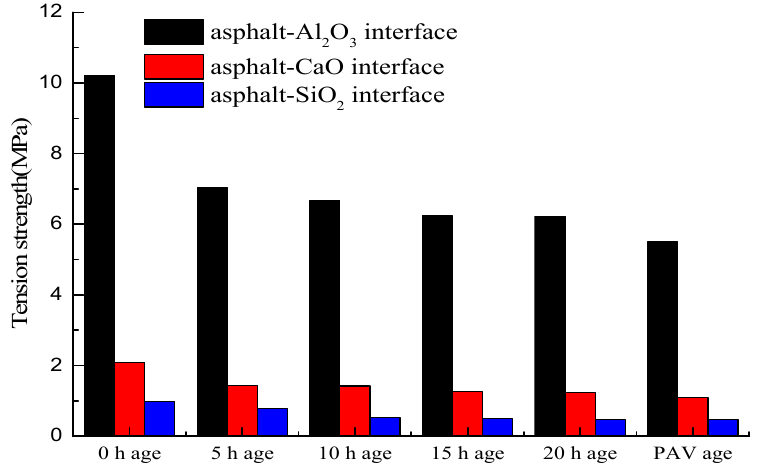
Figure 3. Tensile strength of the asphalt-binder aggregates interface. (PAV = Pressure Aging Vessel)